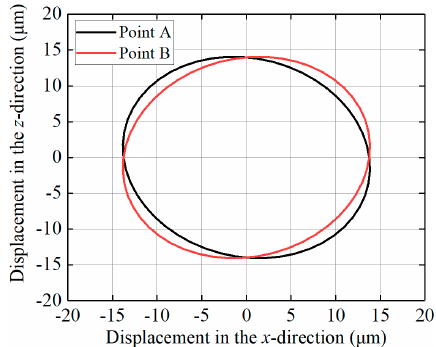
Figure 6. Calculated motion trajectories of the driving feet in the points A and B.